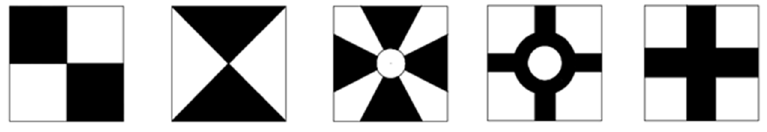
Figure 3. Common artificial markers.